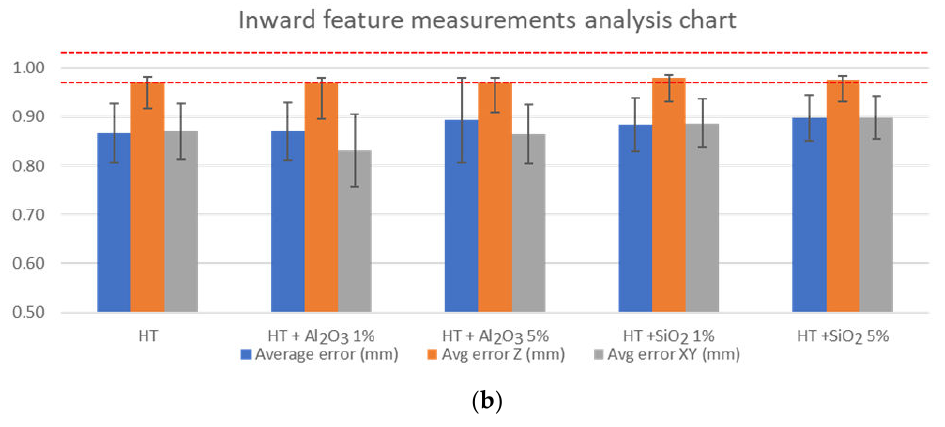
Figure 6. Feature measurements analysis and compliance with tolerance requirements charts. ( a ) Outwrads feature measurements; ( b ) Inward feature measurements analysis charts.